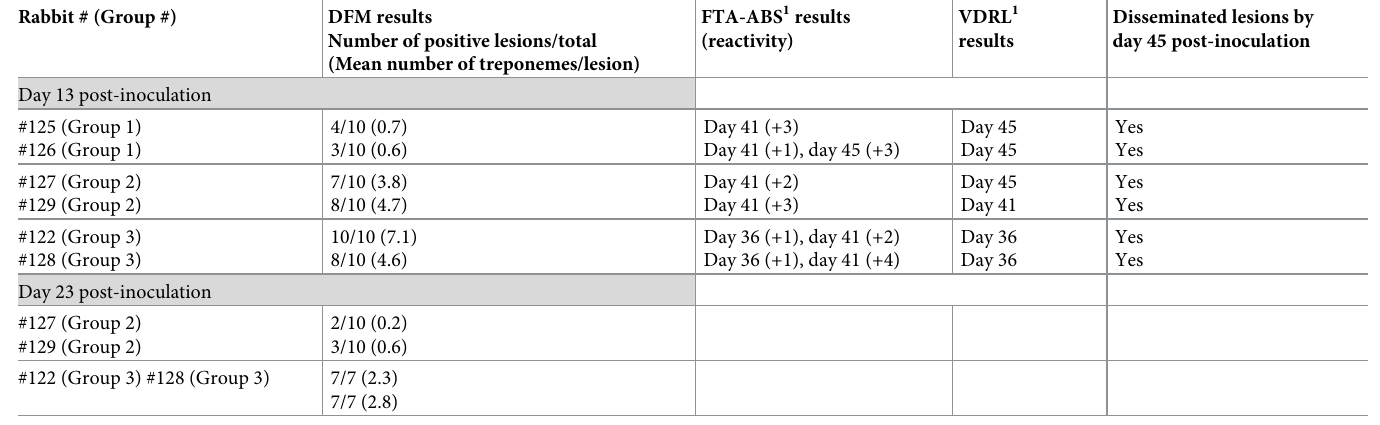
Table 1. DFM, FTA-ABS, and VDRL results.